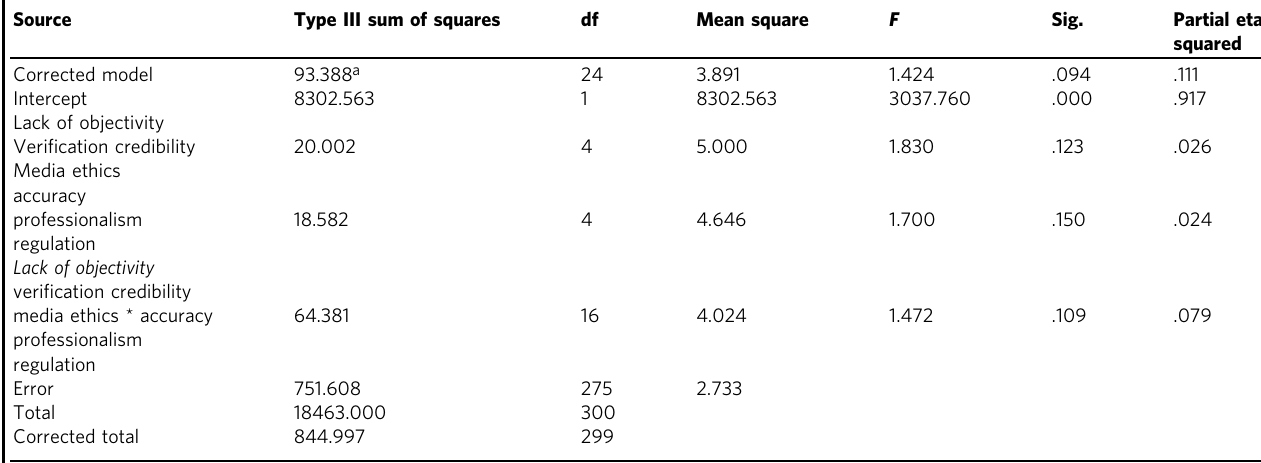
Table 4 Tests of between-subjects effects. Dependent Variable: information accessibility and freedom of